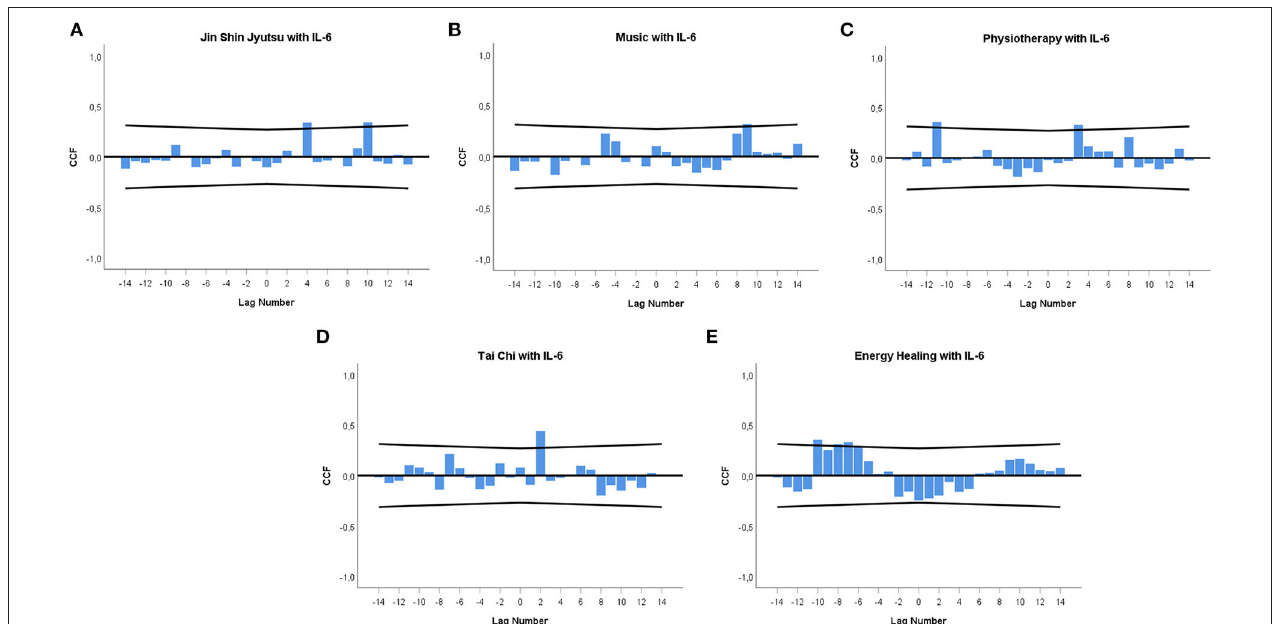
FIGURE 2 | (A–E) Cross-correlation functions (CCFs) between individual CAM techniques and urinary IL-6 concentrations. (A) Jin Shin Jyutsu, (B) Music, (C) Physiotherapy, (D) Tai Chi, (E) Energy healing. Each lag represents a time interval of 12h. Cross-correlation coefficients (bars) reaching the upper or lower limits of the 95% confidence intervals (lines) are significant at p < 0.05. Lag 0 on the x -axis signifies the time of a CAM event. A zero lag significance means that CAM is followed by an IL-6 change during the next 12h. A positive lag significance means that CAM is followed by an IL-6 change, whereas a negative lag significance means that an IL-6 change precedes